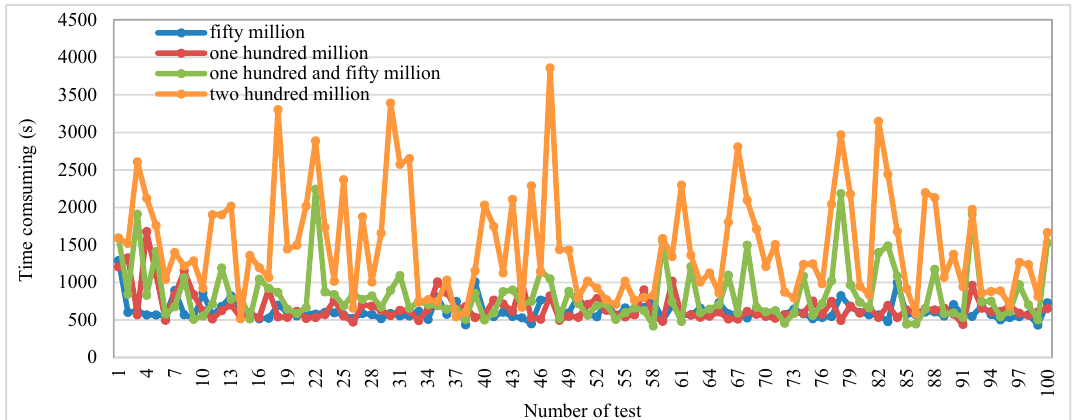
Figure 8. Time consumption in different data volume with ESTRI.